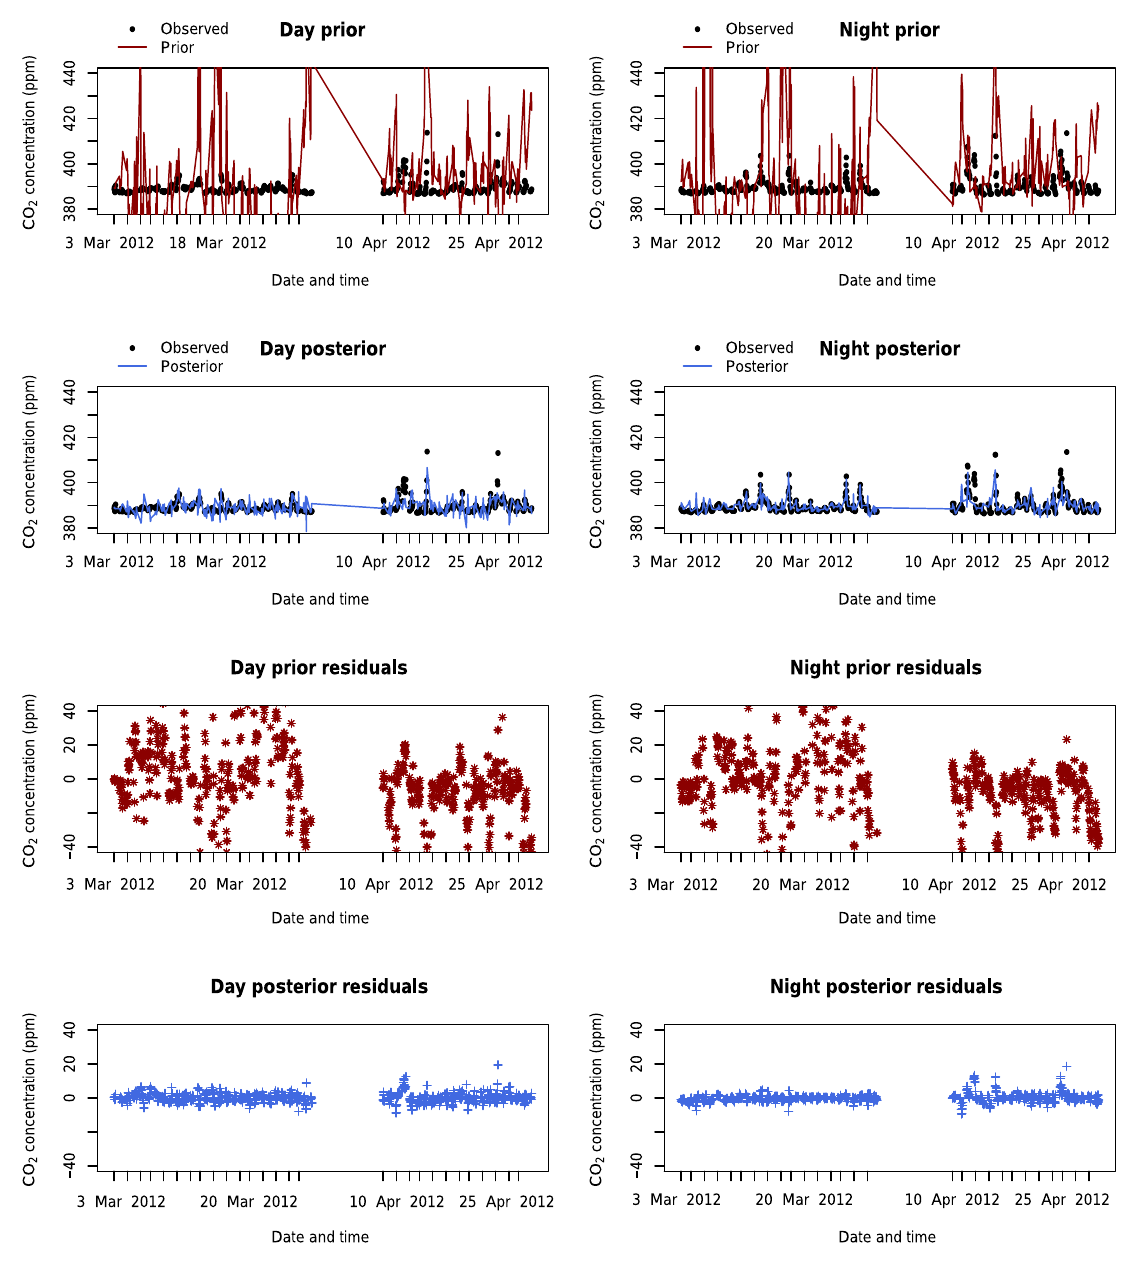
Figure 6. The top four panels provide a time series of the observed, prior, and posterior modelled concentrations at the Robben Island site. The time series is separated into day and night-time periods. The residuals between the observed and prior/posterior modelled concentrations, defined as the difference between the observed and modelled concentrations, are provided in the lower panel four panels. The first 2 months are presented here and remainder of the time series is presented in Sect. 1.4 in the